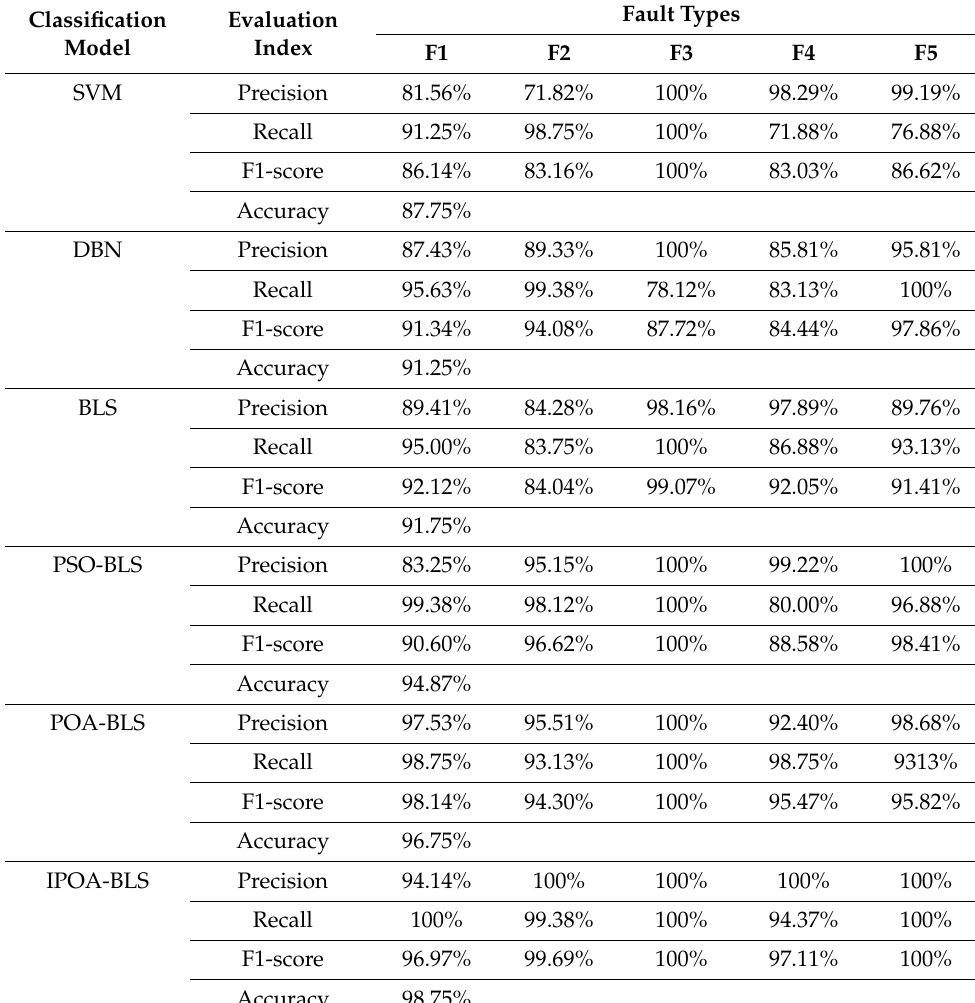
Table 9. Performance indicators of fault classification